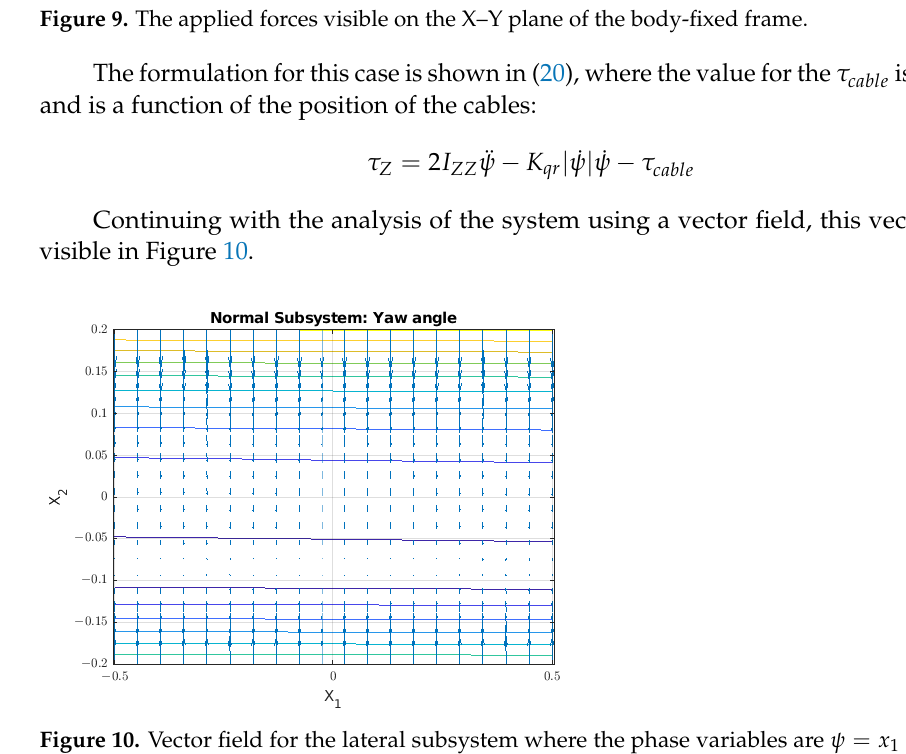
Figure 10. Vector field for the lateral subsystem where the phase variables are ψ = x 1 and ˙ ψ = x 2 . The value for τ cable was selected to be 1